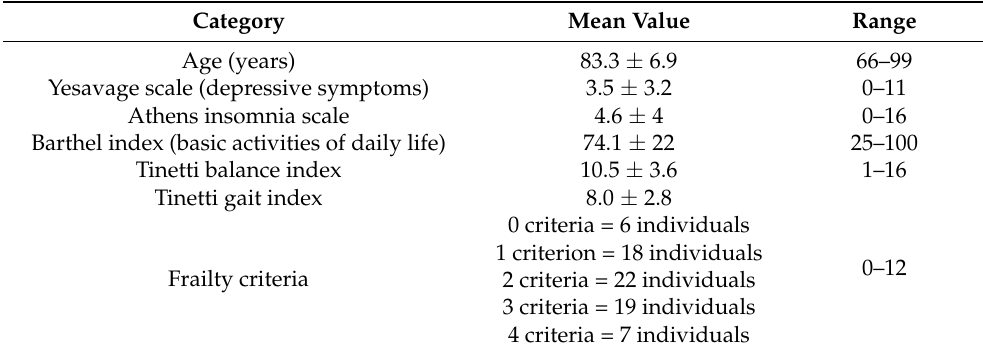
Table 1. Characteristics of the study